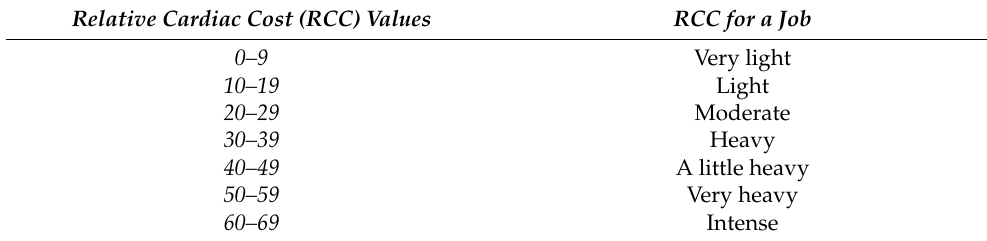
Table 2. Relative Cardiac cost RACC) values for a